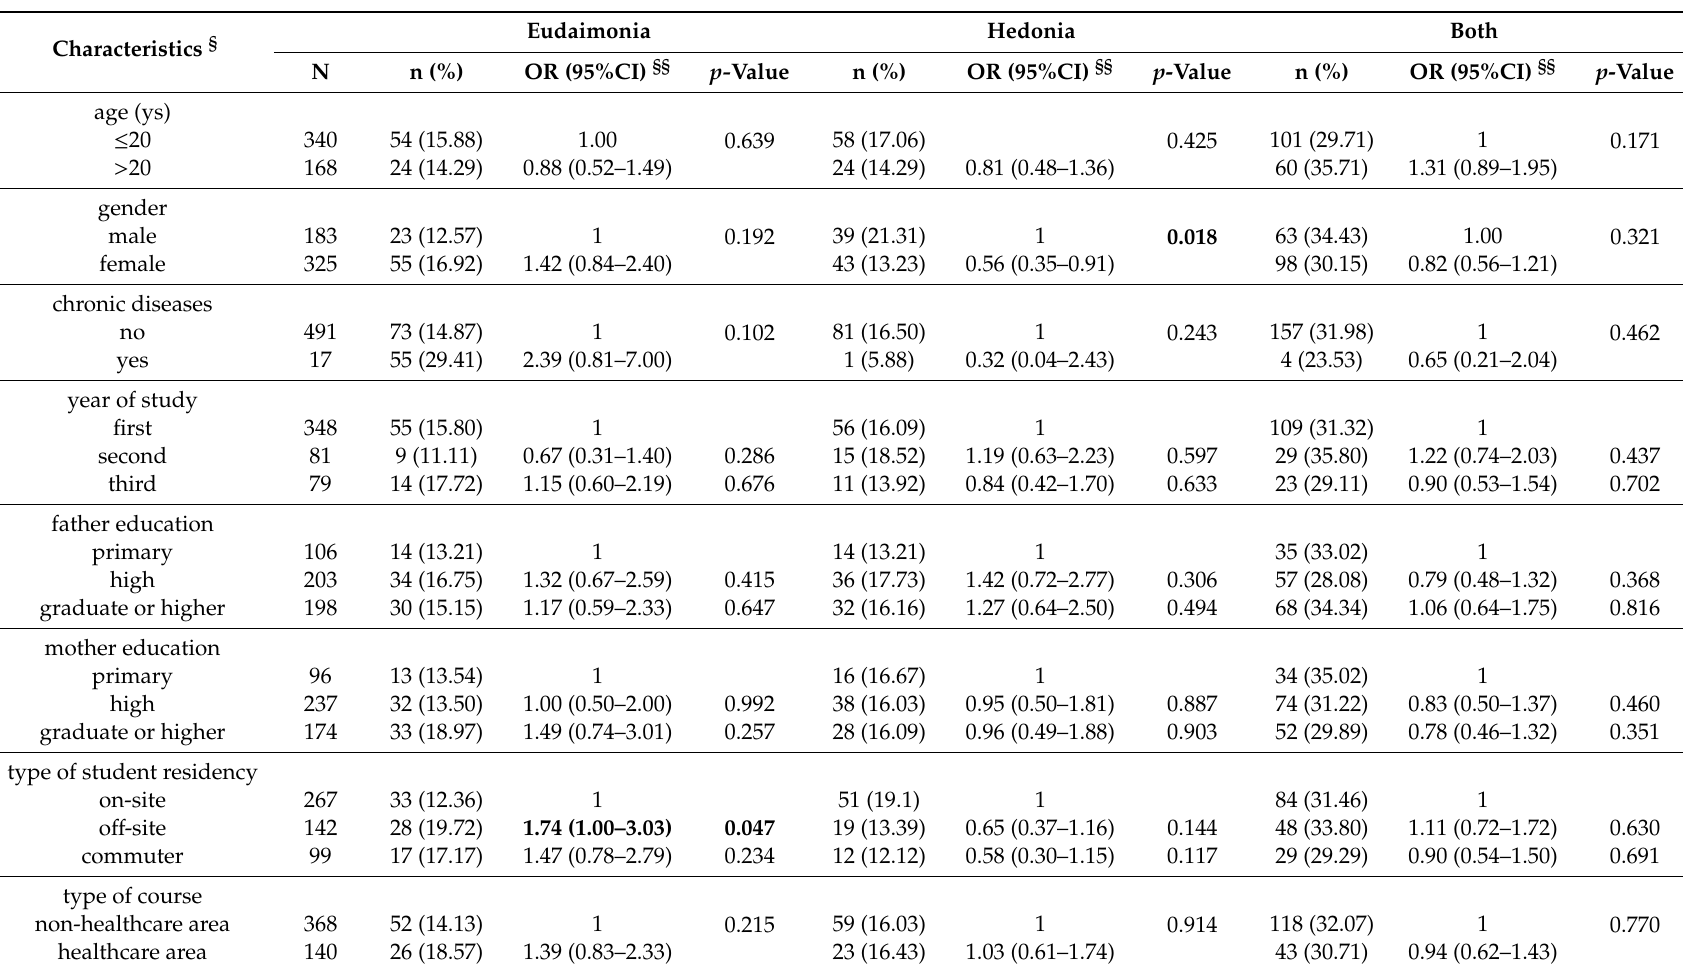
Table 1. Psychological well-being by socio-demographic and health characteristics in a sample of 508 undergraduates of University of Palermo: univariable analysis. Characteristics